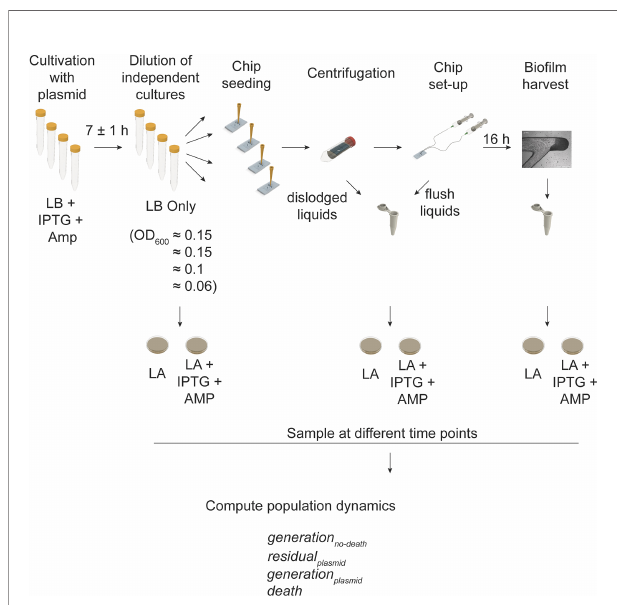
FIGURE 4 | Work fl ow for determining the number of generations and death events. Schematic illustration of the experimental work fl ow with independent starting cultures of E. coli MG1655 harboring the IPTG inducible pAM34 plasmid. The initial cell growth was with ampicillin selection and added IPTG (enabling replication of the plasmid). Each culture was diluted in fresh growth medium (LB without ampicillin and IPTG) to different optical densities (OD 600 = 0.06 to 0.15). The diluted cells were used as the inoculum for seeding of four independent chips. Cultivation of bio fi lms was allowed for 16 h before harvesting of the entire bio fi lm from the growth chambers. Sampling at different points of the work fl ow was carried out in order to determine the cell population and plasmid dynamics by plating on selective (LA + IPTG + AMP) and nonselective (LA) growth medium agar dishes. Population dynamics were then estimated from the calculated colony forming units and according to the here described mathematical models (see Materials and Methods